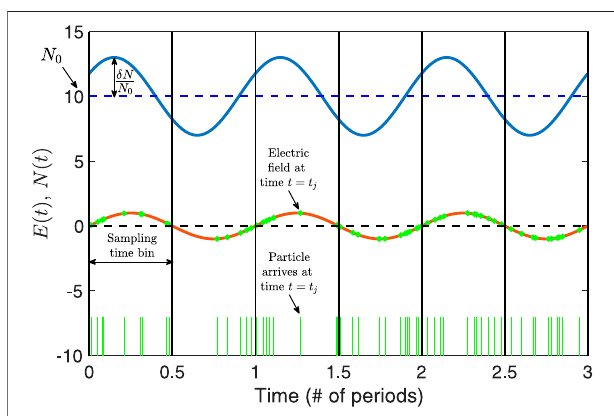
FIGURE 4 | Demonstration of the concept underlying the PATCH algorithm: the variation of the particle number in a particular phase bin Δ x Δ v is given by N ( t ) (blue) and the electric fi eld E ( t ) (red). Individual particles, with a probability of detection proportional to N ( t ), arrive at discrete times t j (verticalgreenlines).ThePATCHcorrelation, C τ ′ givestherateofworkdoneby the electric fi eld on the particles, and it is essentially the summed values of the electric fi eld at the particle arrival times. From Verniero et al.